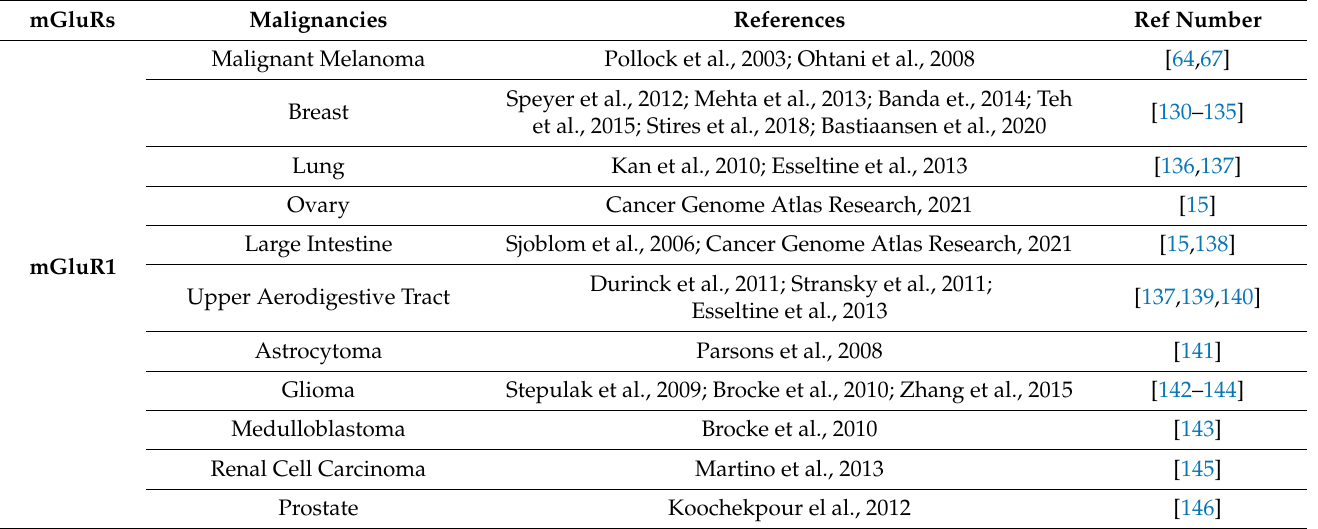
Table 1. mGluRs in Various